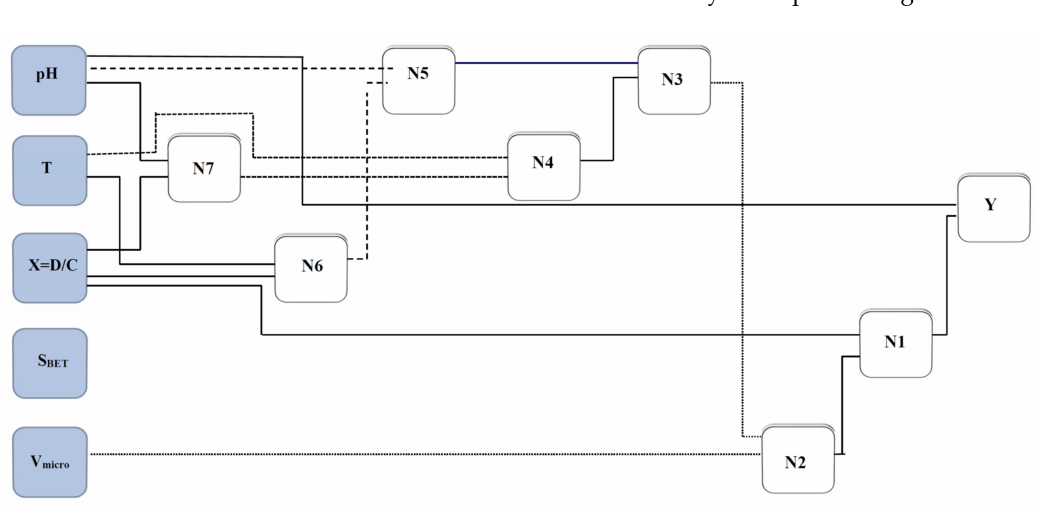
Figure 2. A simplified structure of the presented group method of data handling (GMDH) for estimating asphaltenes adsorption. Table 3. Correlations developed by group method of data handling (GMDH) for predicting the amount of asphaltenes adsorption onto